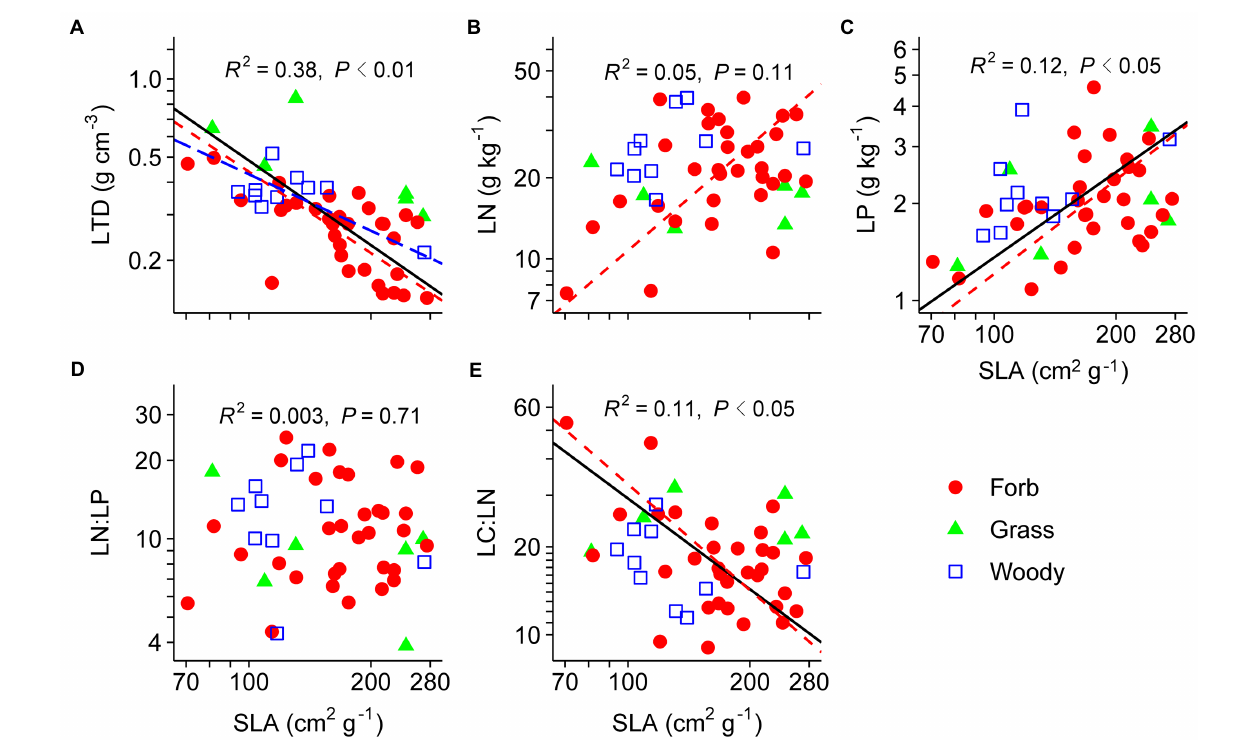
FIGURE 1 | Relationships between specific leaf area (SLA) and leaf tissue density (LTD; A ), leaf nitrogen content (LN; B ), leaf phosphorus content (LP; C ), leaf N:P ratio (LN:LP; D ), and leaf C:N ratio (LC:LN; E ). Species means are shown for forbs (closed circle), grasses (triangle), and woody species (open square). Solid lines ( R 2 and p values) represent linear fits across all species, red dashed lines represent linear fits for forbs, and blue long-dashed lines represent linear fits for woody species. Type II model was used for all linear fits. The log 10 scale was used on both x - and y